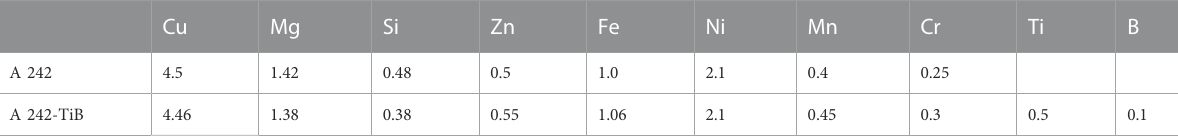
TABLE 1 Chemical compositions of the standard and modi fi ed A 242